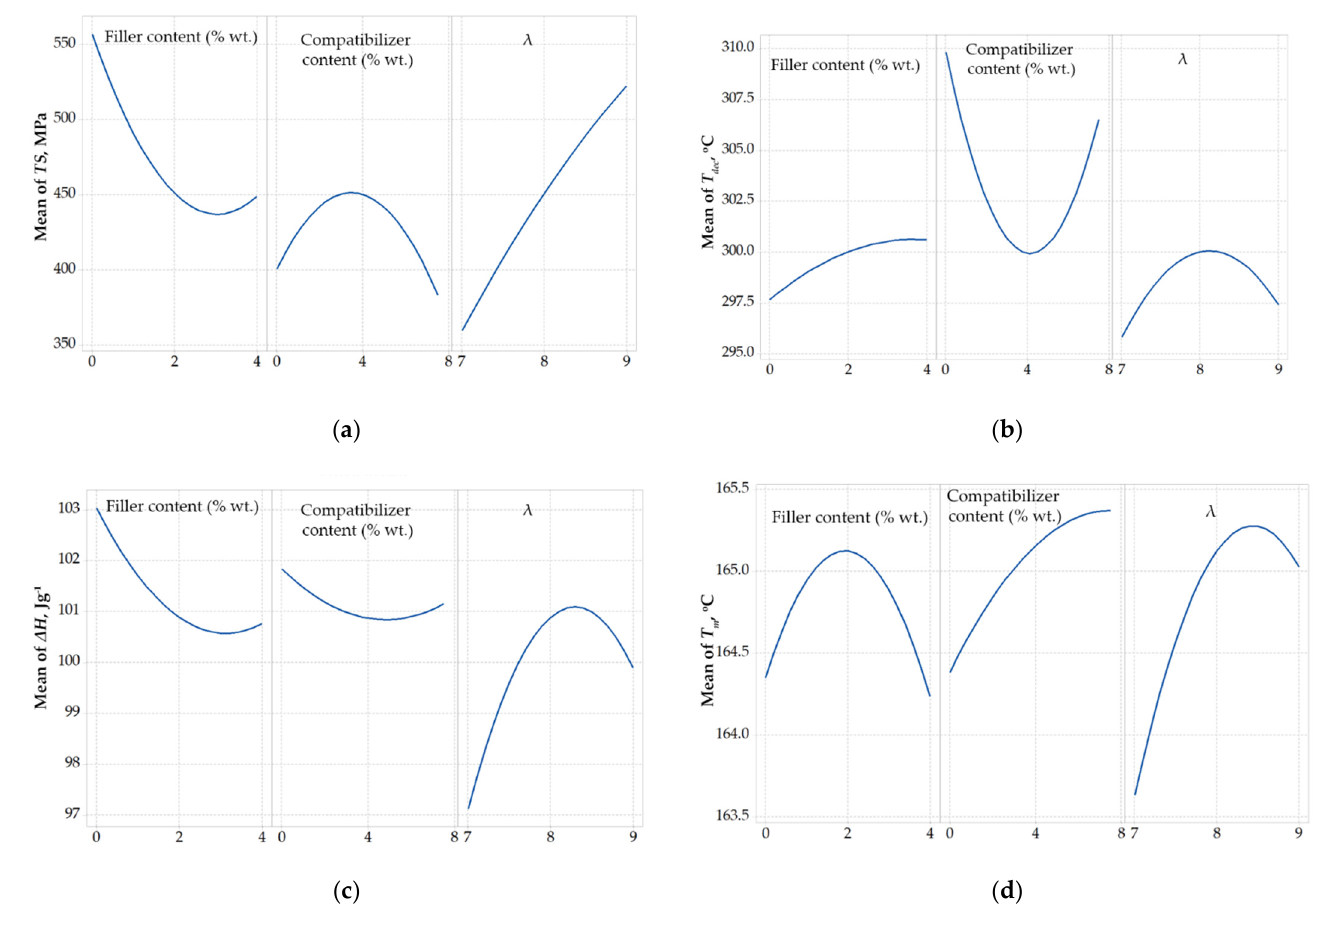
Figure 1. Correlation of design variables with ( a ) Tensile strength, TS , ( b ) Onset decomposition temperature, T dec , ( c ) Heat of fusion, Δ Η , and ( d ) melting point, T m , regarding composites with talc. temperature, T dec , ( c ) Heat of fusion, ∆ H , and ( d ) melting point, T m , regarding composites with